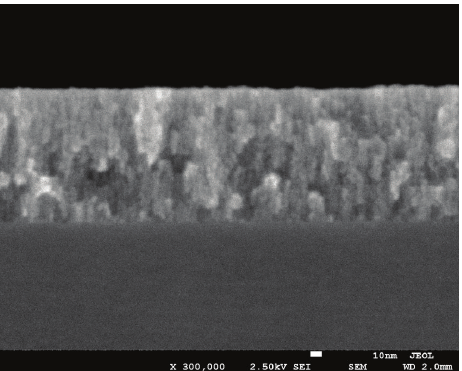
Figure 5: EDS spectrum of sample TAD on the top surface of the sample. The identified peaks are labeled according to atomic species and show the strongest peaks belonging to titanium and oxygen.